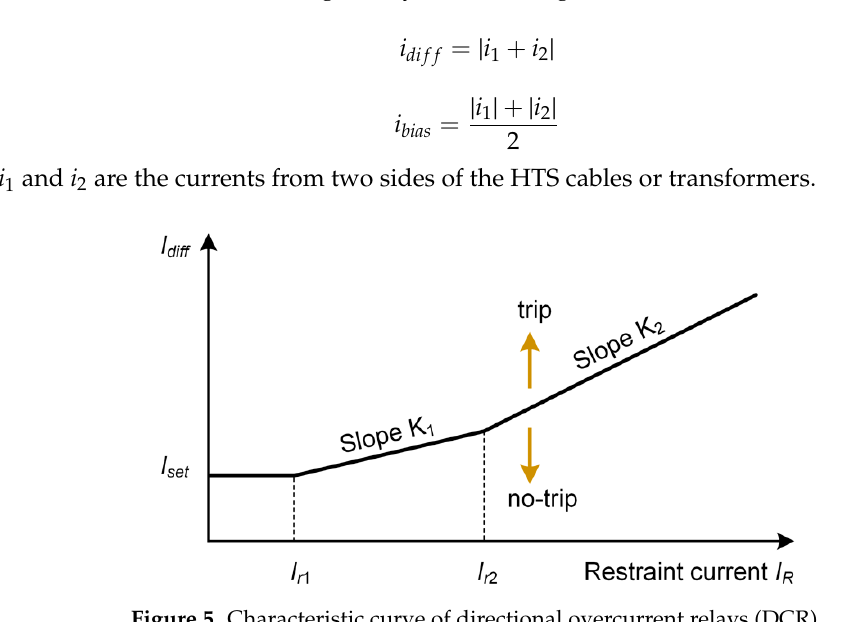
Figure 4. Process of designing protective relays.